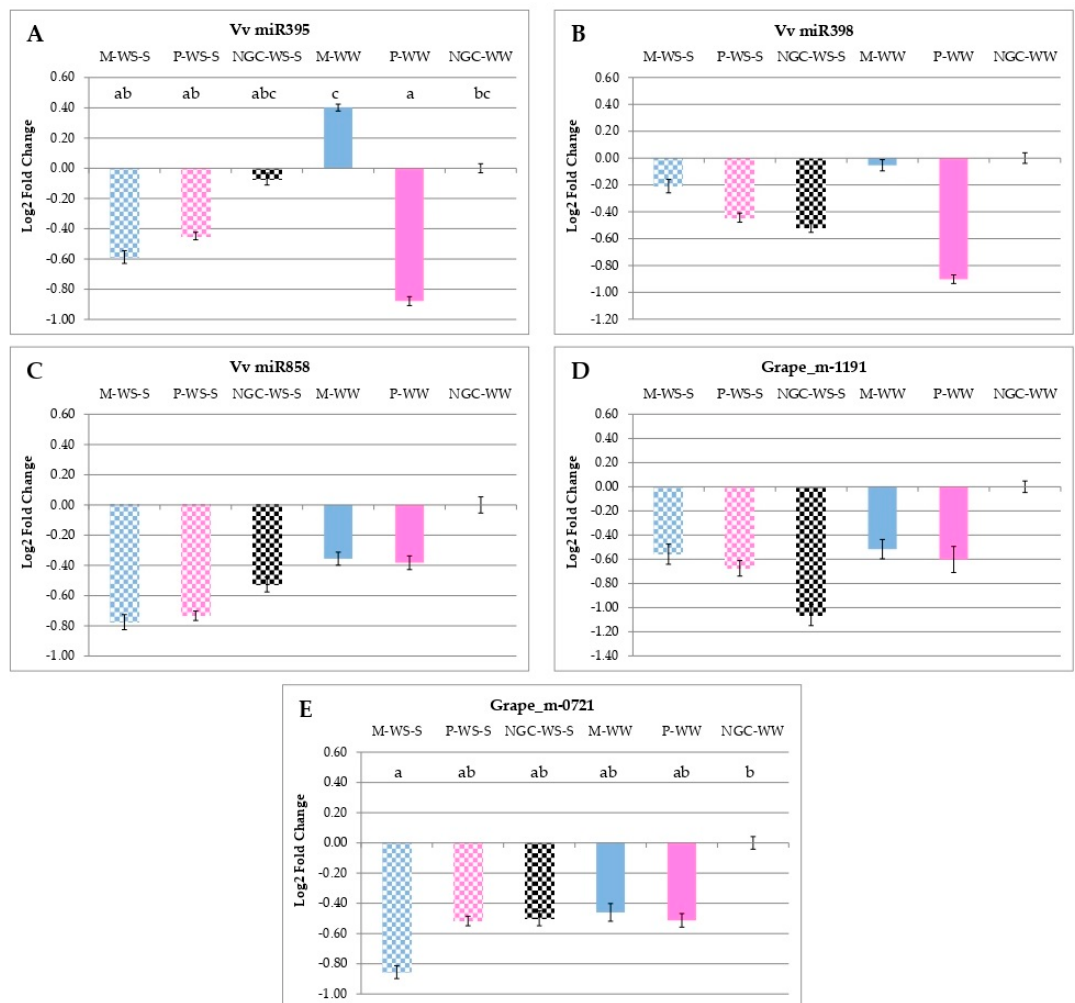
Figure 6. Expression profiles of the five selected miRNAs obtained by qRT-PCR. Log2 Fold Change, calculated with the ∆∆ Ct method, of miR395 ( A ), miR398 ( B ), miR858 ( C ), Grape_m-1191 ( D ), and Grape_m-0721 ( E ). The error bars indicate the standard deviation. Sample names: M-WS-S, vines grafted on Mgt 101-14 subjected to severe water stress (in checkered light blue); P-WS-S, vines grafted on 1103 Paulsen subjected to severe water stress (in checkered pink); NGC, not grafted control vines subjected to severe water stress (in checkered black); WS, water stress; M-WW, well-watered vines grafted on Mgt 101-14 (in light blue); P-WW, well-watered vines grafted on 1103 Paulsen (in pink); NGC-WW, well-watered not grafted vines (control). Different letters indicate significant differences (LSD test, P < 0.05).